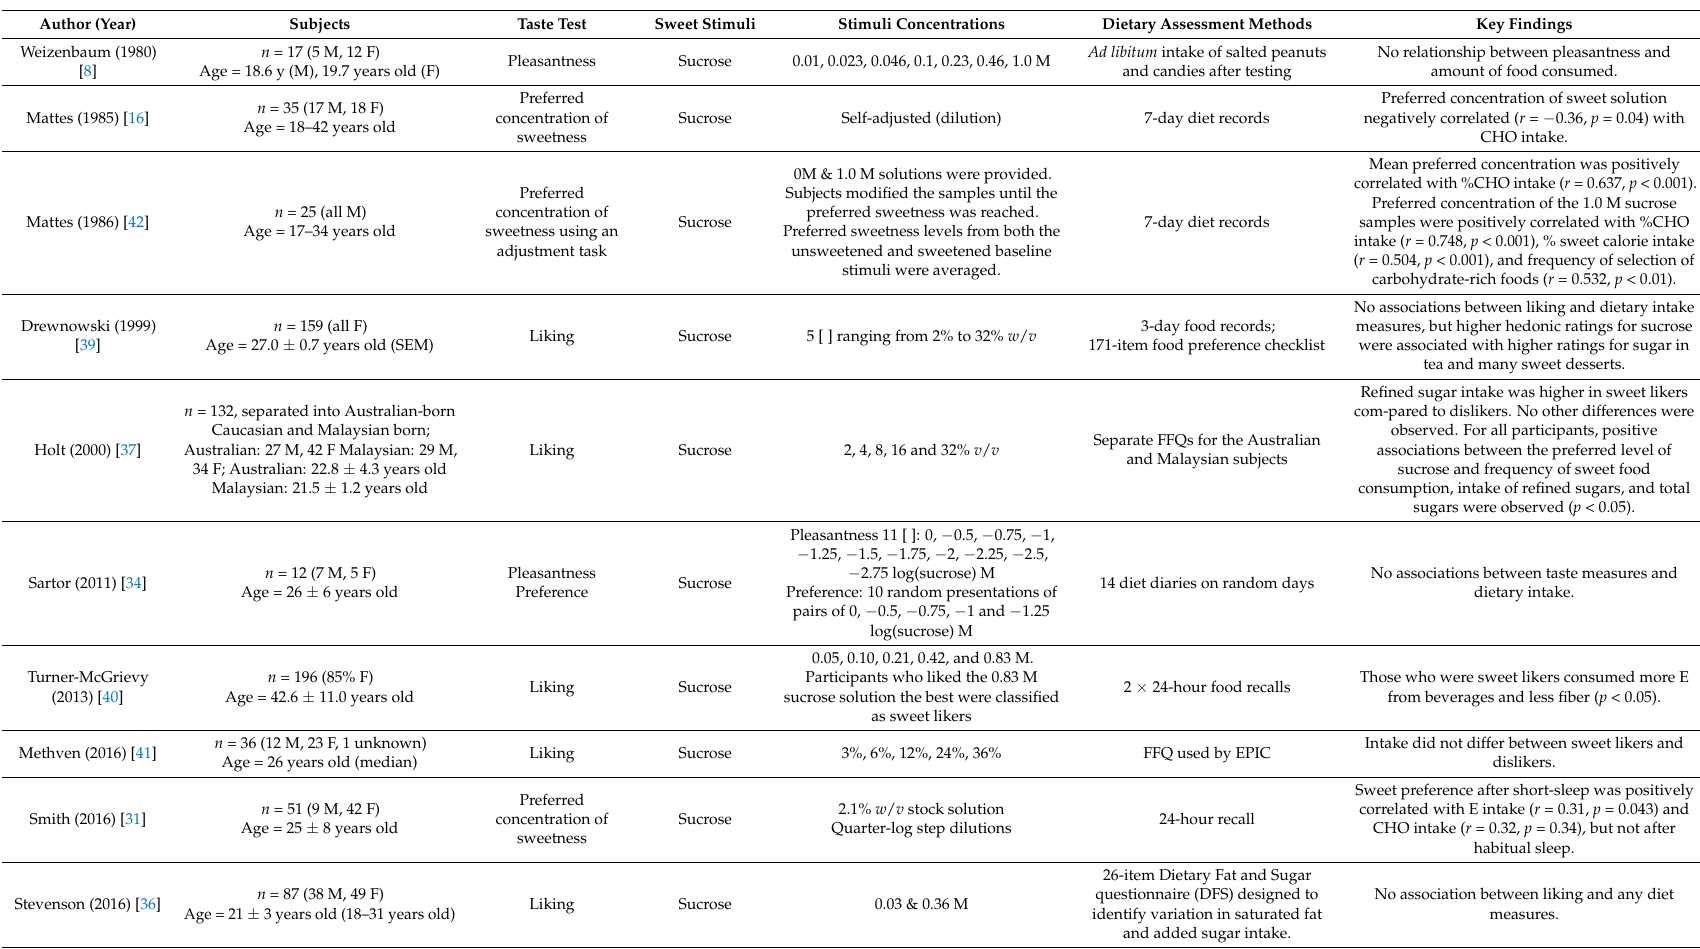
Table 3. Hedonic Studies Examining Taste-Diet